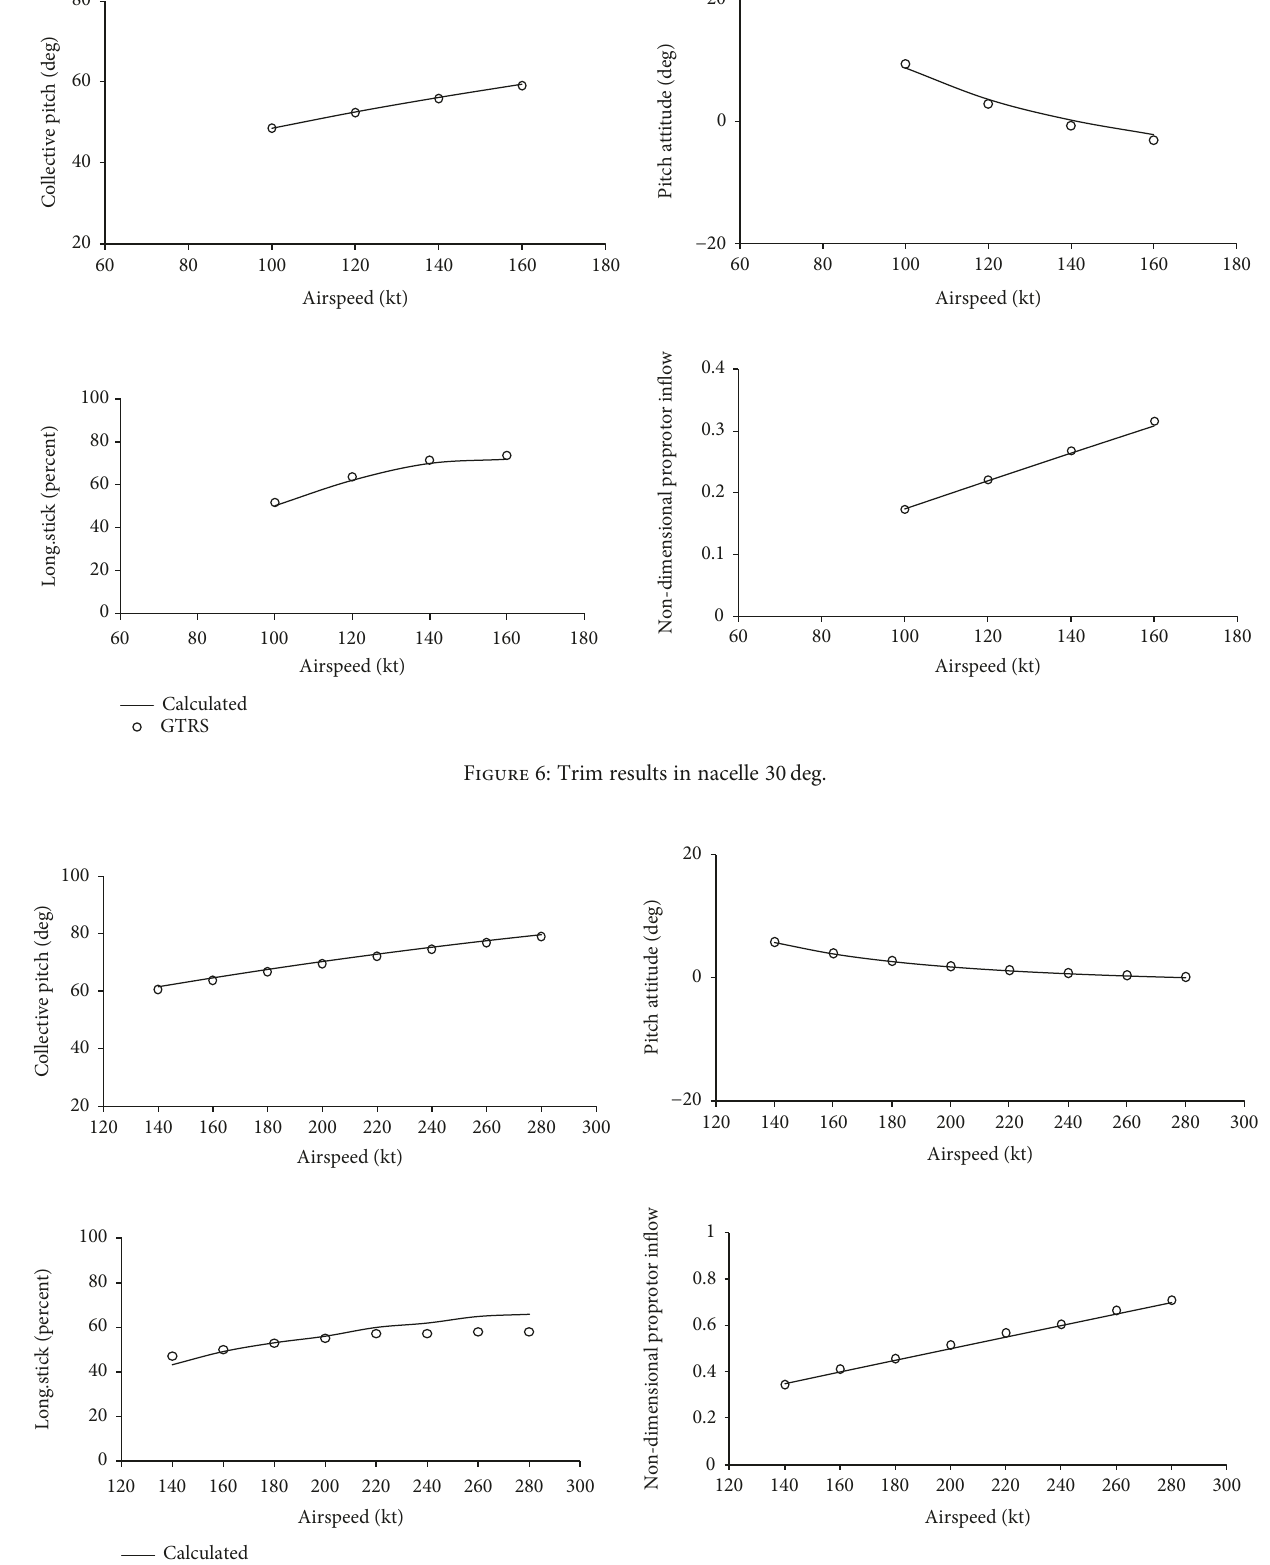
Figure 7: Trim results in airplane